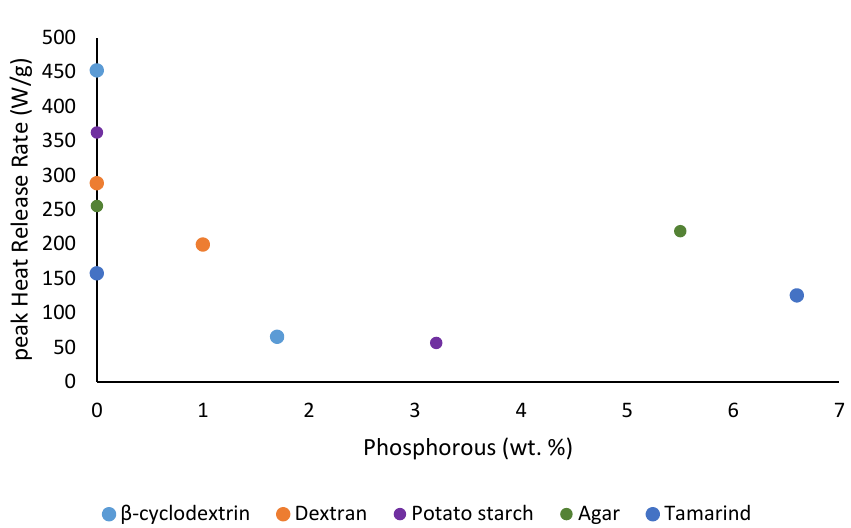
Figure 15. Plot of the heat release capacity versus phosphorus content (wt. %) of the substrates.